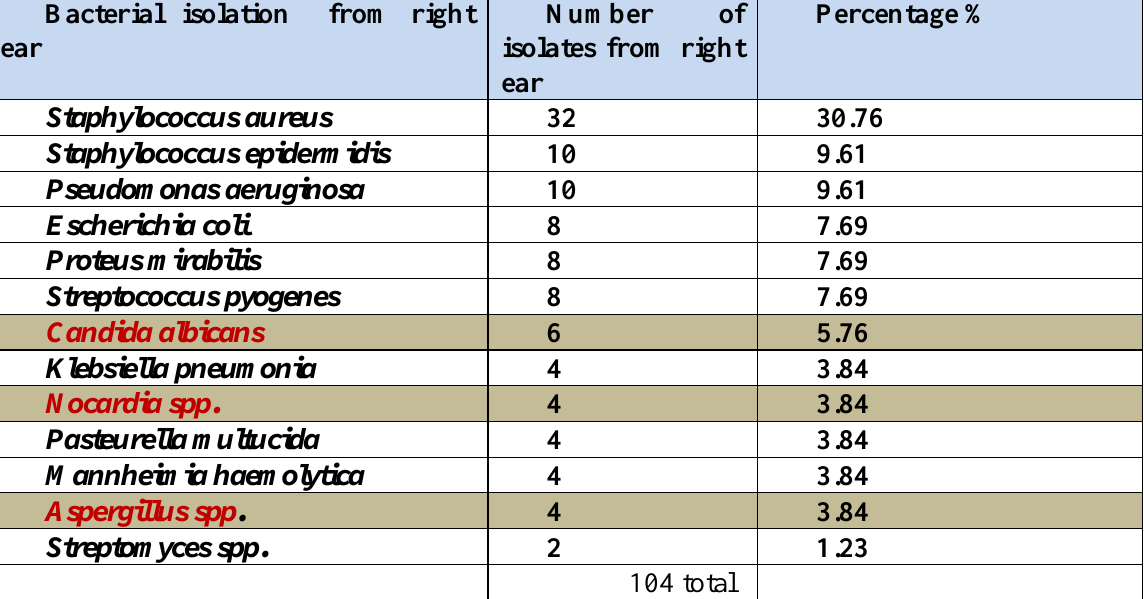
Table 1: Numbers of bacteria and fungus species isolates from infected right